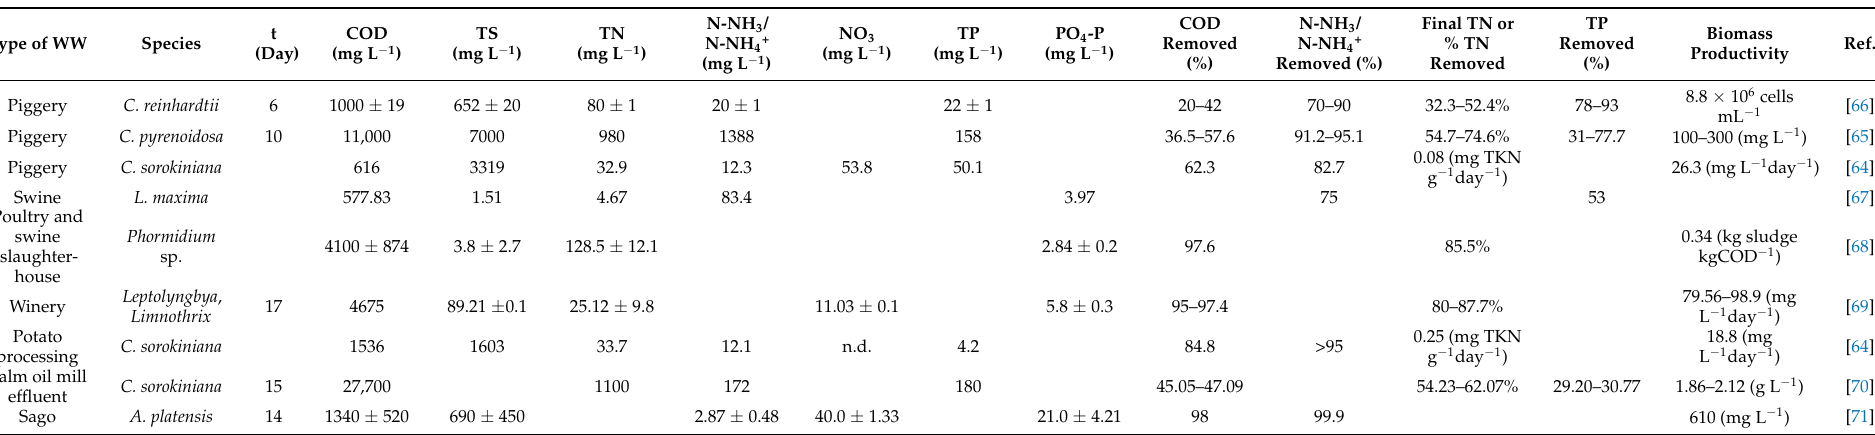
Table 3. Agroindustrial wastewater treatment using microalgae. COD: Chemical Oxygen Demand, TS: Total Solids, TN: Total Nitrogen, NH 3 -N: ammoniacal nitrogen, NH 4 -N: ammonium, NO 3 : nitrate, TP: Total Phosphorus, PO 4 -P: